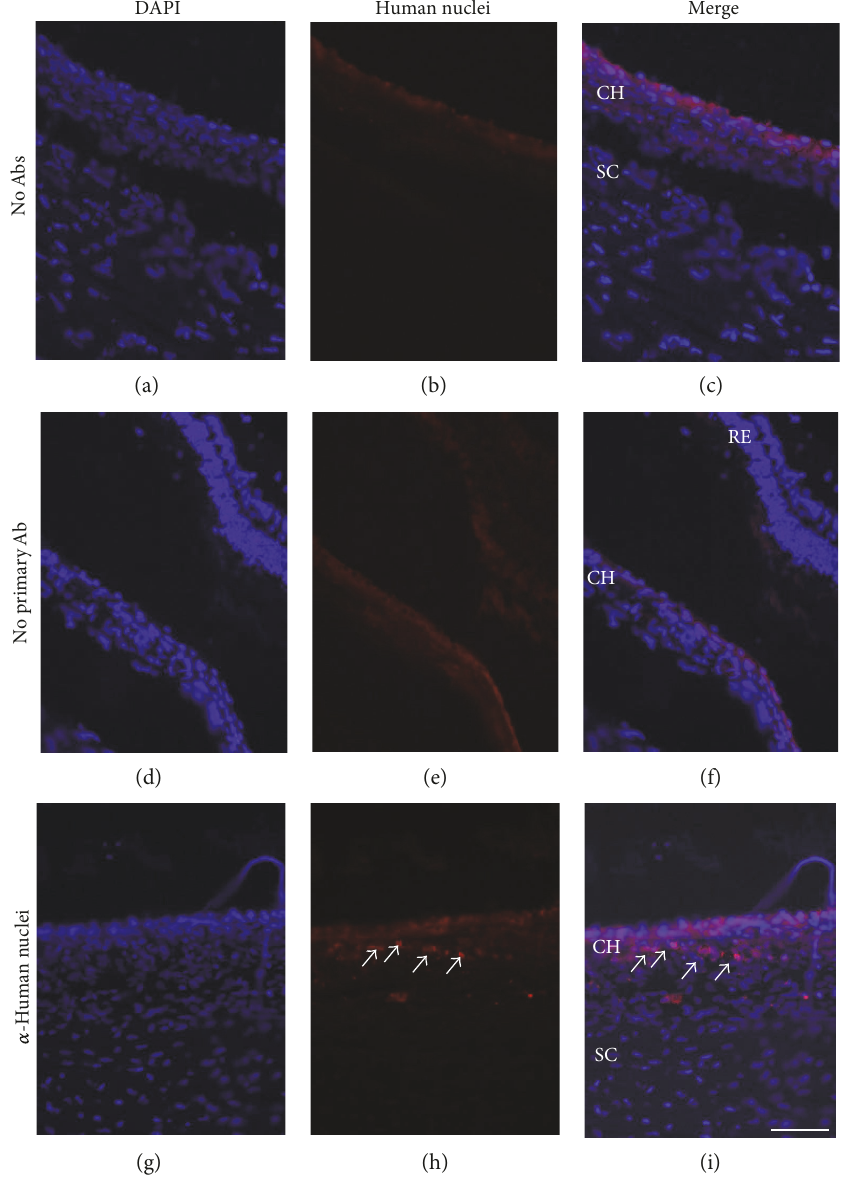
Figure 3: Transplanted hBMSCs identi fi ed in the EVSC 10 weeks following transplantation. Frozen sections of rabbit eyes removed 10 weeks followingtransplantationof nonlabeledhBMSCswere stainedwithanti-human nuclei antibody (red, (h) and(i)). White arrowshighlightsome of the transplanted cells. Sections stained with DAPI only (no antibodies, (a), (b), and (c)) or incubated with secondary antibody only (d), (e), and (f) are presented as control. All sections were counterstained with DAPI (blue). Ab: antibody; CH: choroid; SC: sclera; RE: retina. Scale bar 100 μ